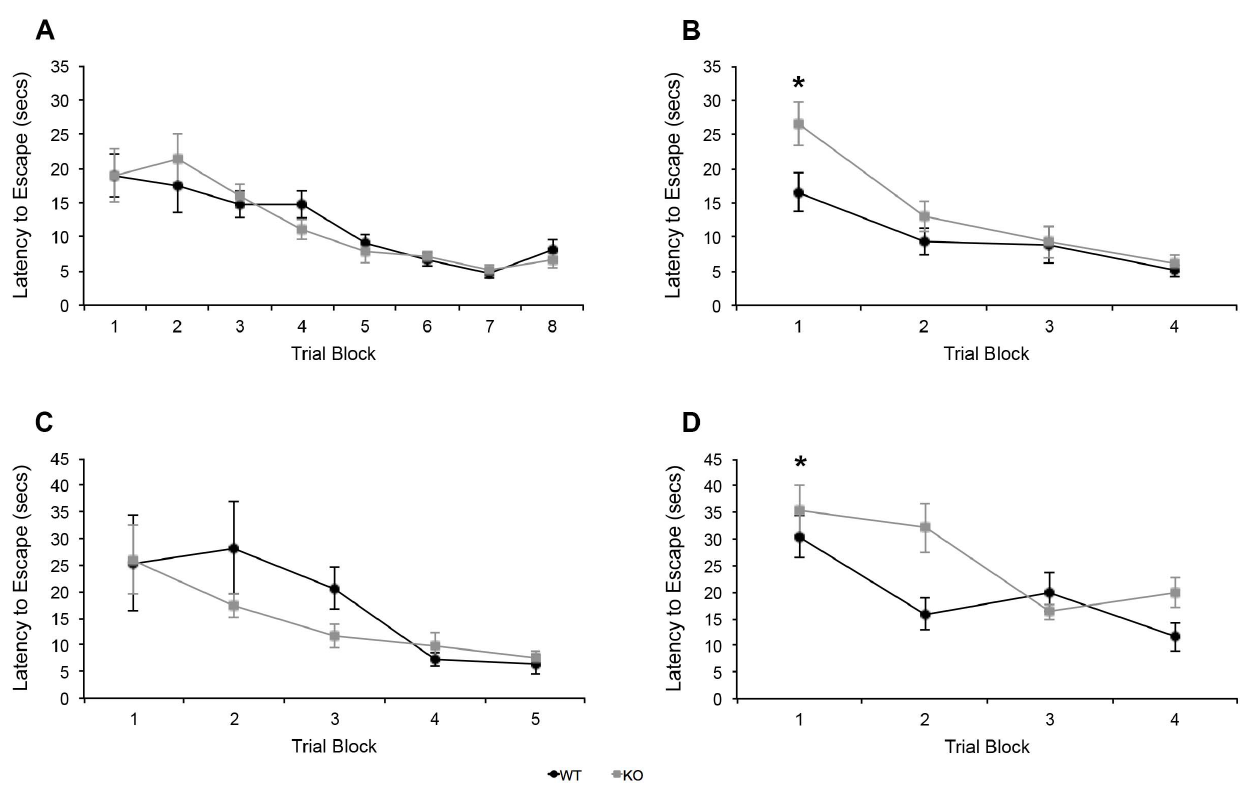
Figure 1. Latencies to escape the Morris water maze for PTN KOs (n=13) and WTs (n=13). (a) Spatial version, first maze; (b) cued version, first maze; (c) cued version, second maze; (d) spatial version, second maze. *p= ,